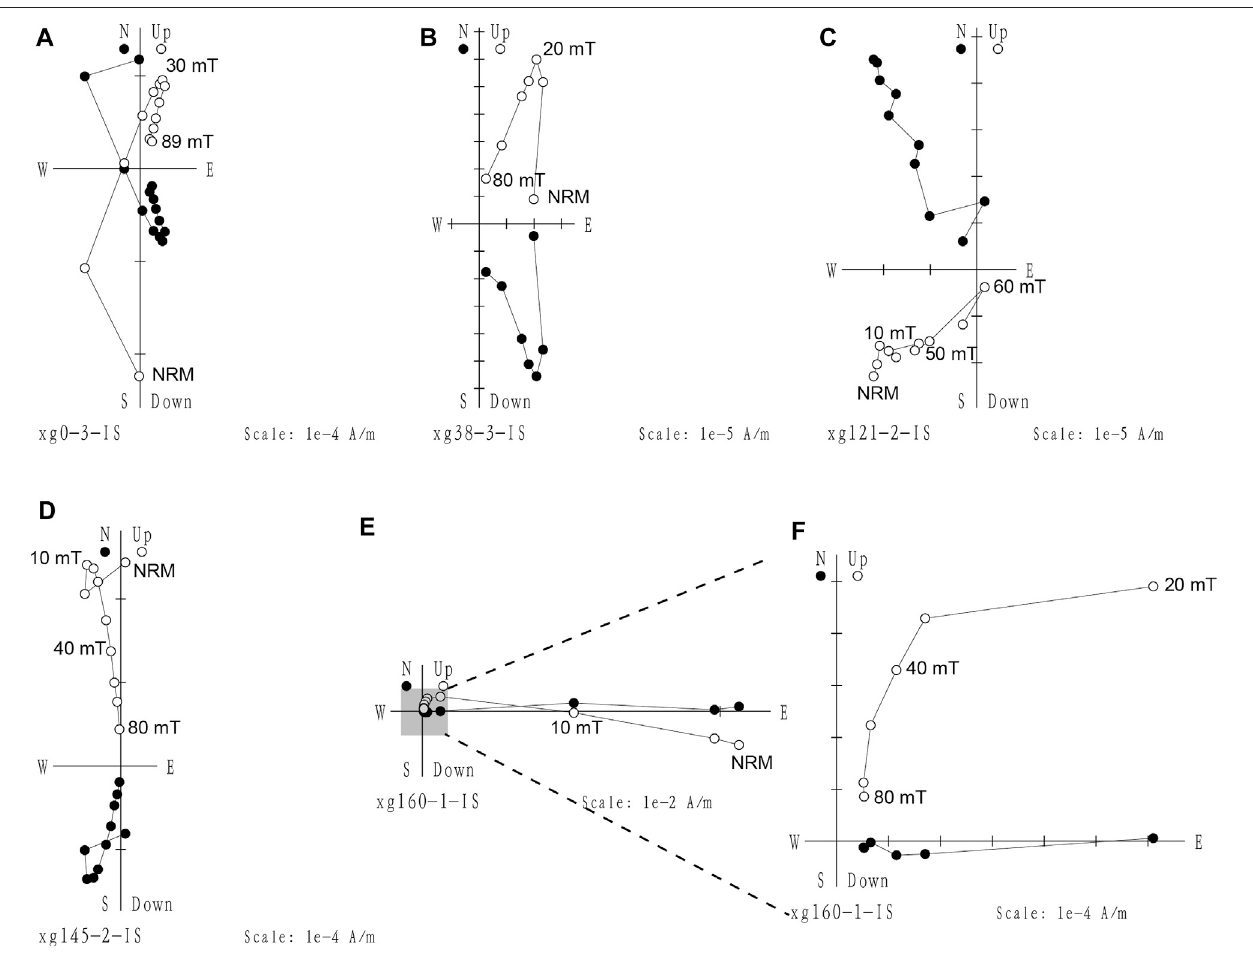
FIGURE 7 | Orthogonal (Zijderveld) vector plots of representive specimens from the Zongpu limestones in the Gamba area. All demagnetization data are from Yi et al. (2011). Polished thin sections were processed on the fresh end materials of the paleomagnetic specimens. Block limestone sample was collected for magnetic extraction from the top of Section A in Yi et al. (2011). Directions are plotted in-situ ; solid and open circles represent vector endpoints projected onto horizontal and vertical planes, respectively.